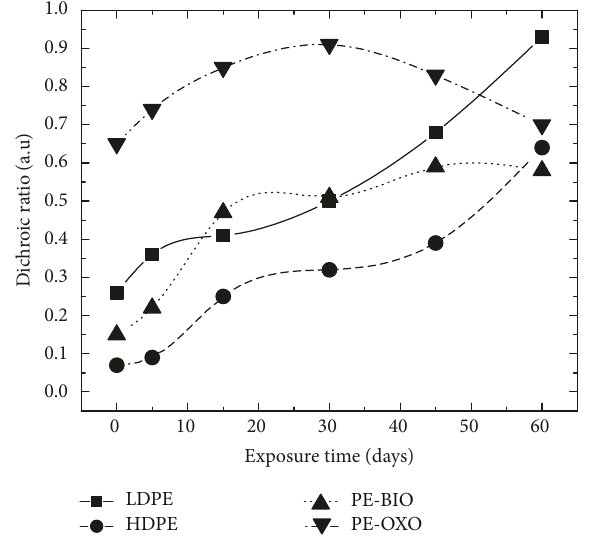
Figure 3: Vinyl index ( 𝐼 V ) of the LDPE ( ◼ ), HDPE ( e ), PE-BIO ( 󳵳 ), and PE-OXO ( 󳶃 ) films exposed to UV-B radiation.